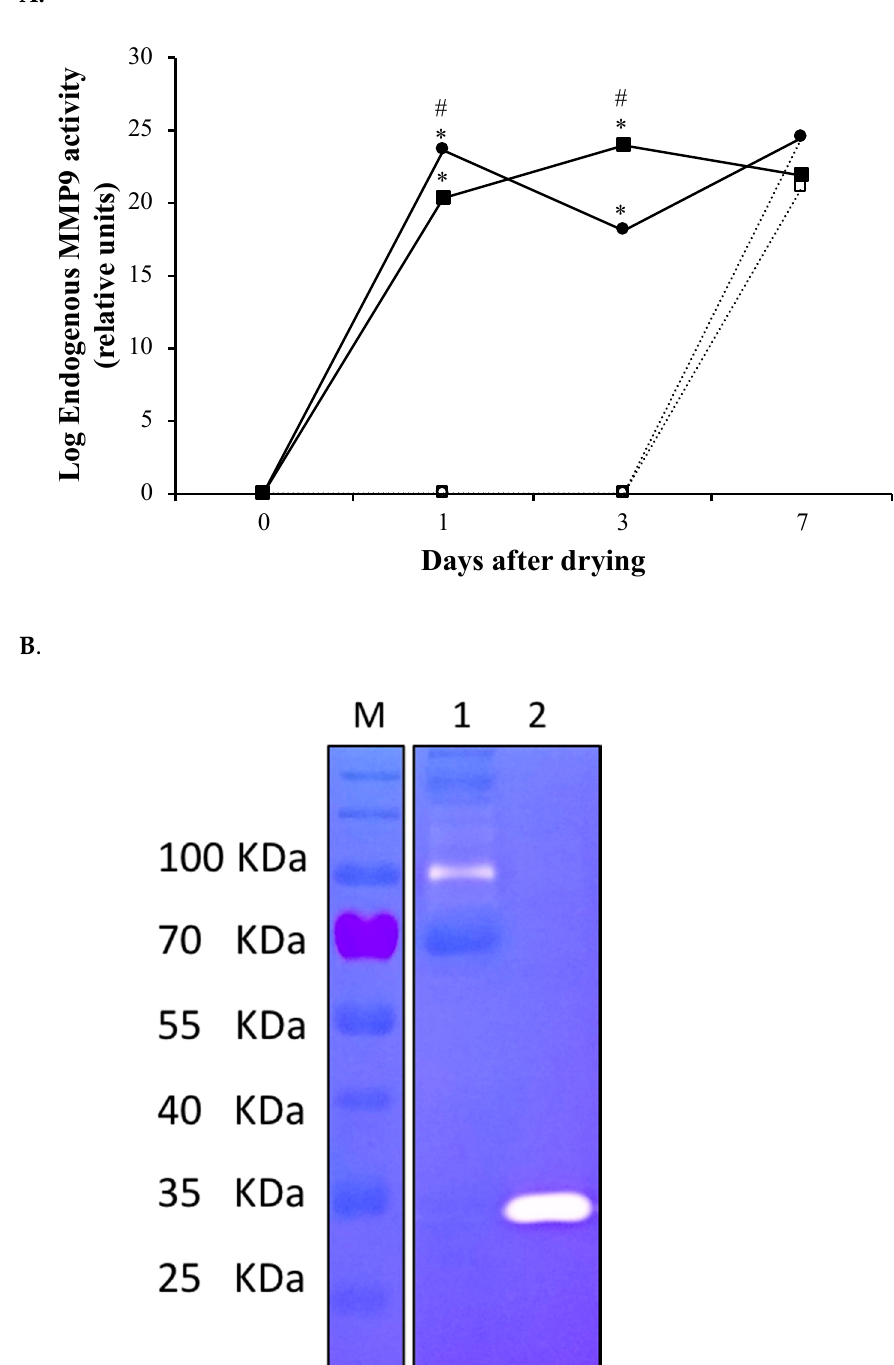
Figure 2. ( A ) Endogenous matrix metalloproteinase-9 (MMP-9) activity in mammary secretions at 0, 1, 3, and 7 d after dry-off of pregnant dairy-cows analyzed by zymography. Continuous lines indicate MMP-9 treatments, discontinuous lines depict controls. Filled circles correspond to soluble rtMMP-9 treatment and empty circles to its control, filled squares represent IBs treatment and empty squares to its control. Asterisks indicate significant differences ( p < 0.05) between treatment and control whereas pound sign indicates differences between treatments. ( B ) Zymogram comparing the metalloproteinase activity (white bands) obtained in mammary secretion samples (lane 1) or loading directly the rtMMP-9 (lane 2). The Lane M corresponds to the molecular weight marker.